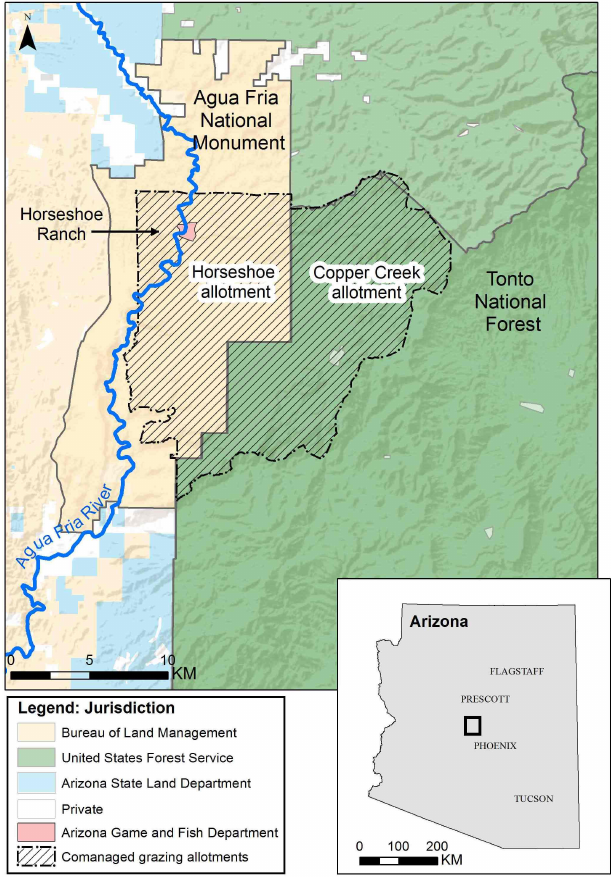
Fig. 1 . Agua Fria Adaptive Co-Management Area, Arizona,